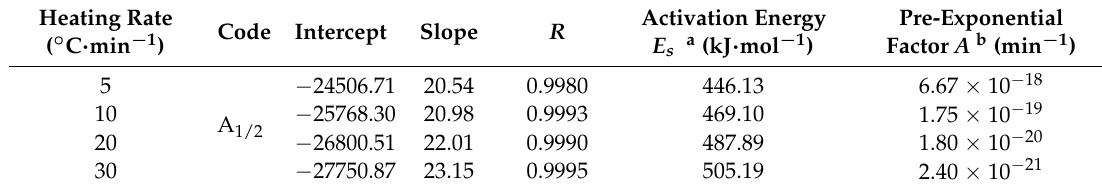
Table 5. Kinetic parameters to most probable mechanism function at different heating rate.